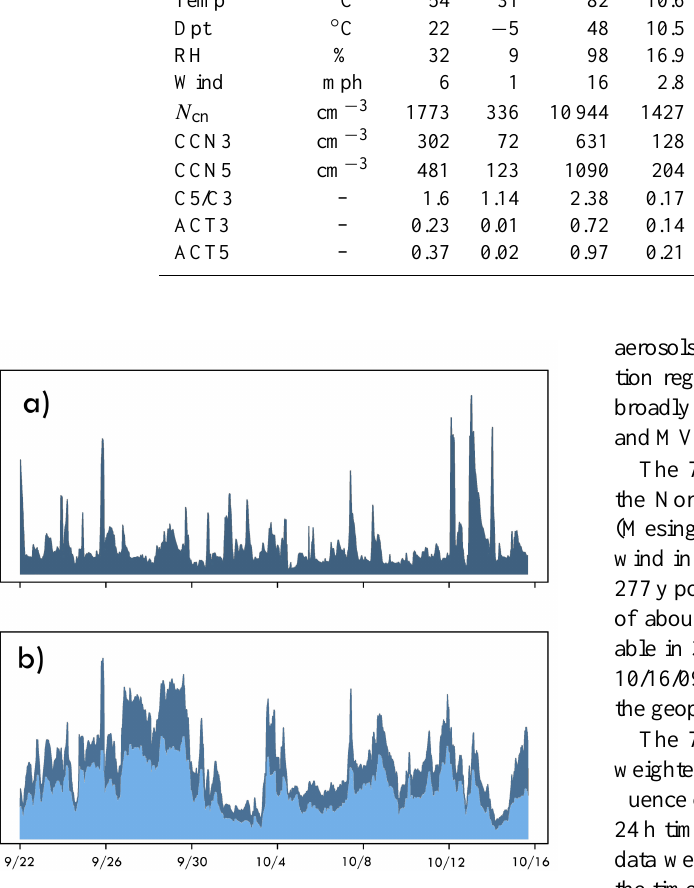
Fig. 3. Time series of (a) N cn and (b) N ccn ( N ccn at SS = 0.3% shown in light blue, N ccn at SS = 05% shown in dark blue) observed at MVNP during the ISPA field